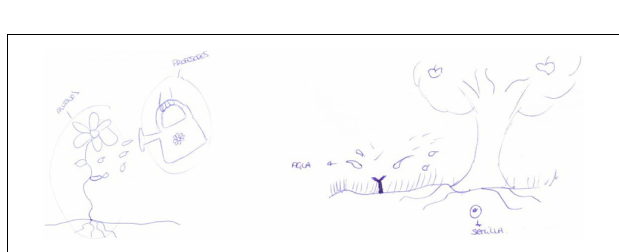
FIGURE 3 | E26’s drawings for the metaphor of the gardener for the teacher and the seed for the pupils (pre-test and post-test).